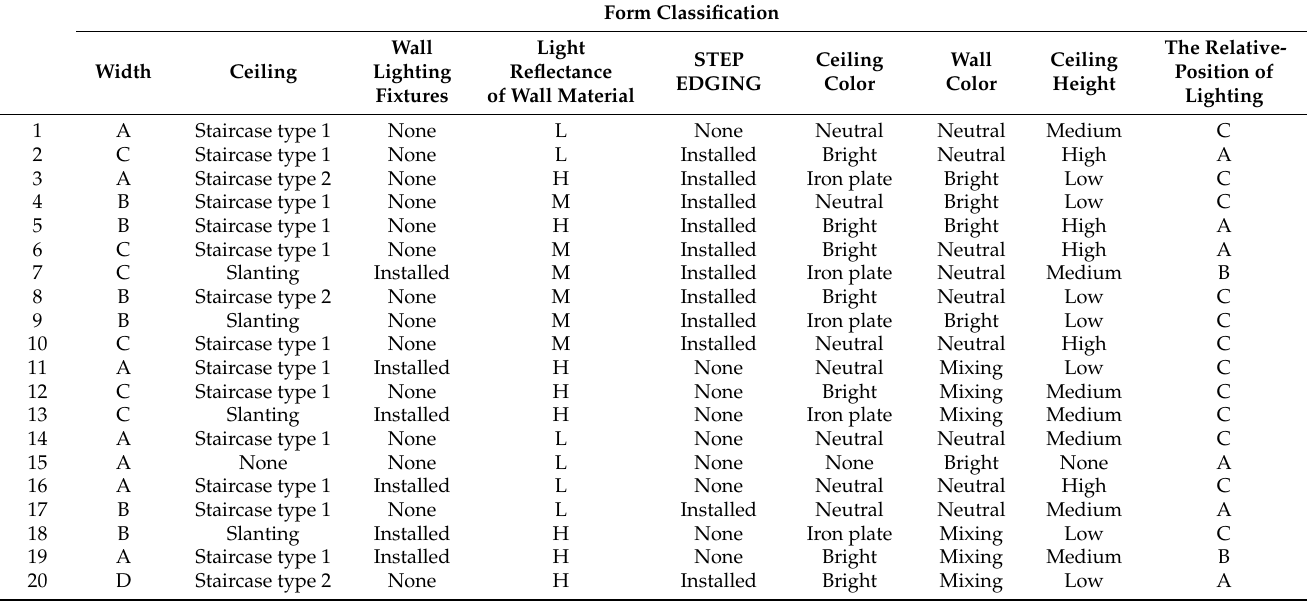
Table 2. Stair morphology classification